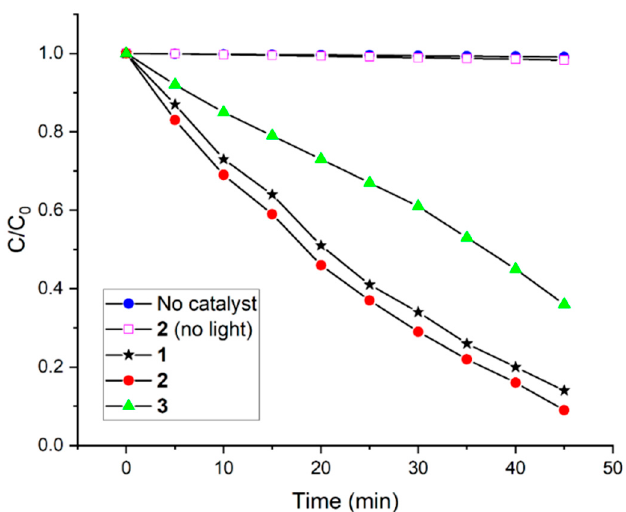
Figure 4. The photocatalytic degradation of AO dye in an aqueous solution (pH 7, T = 298 K) under visible-light irradiation in the presence of photocatalysts 1 , 2 , and 3 .